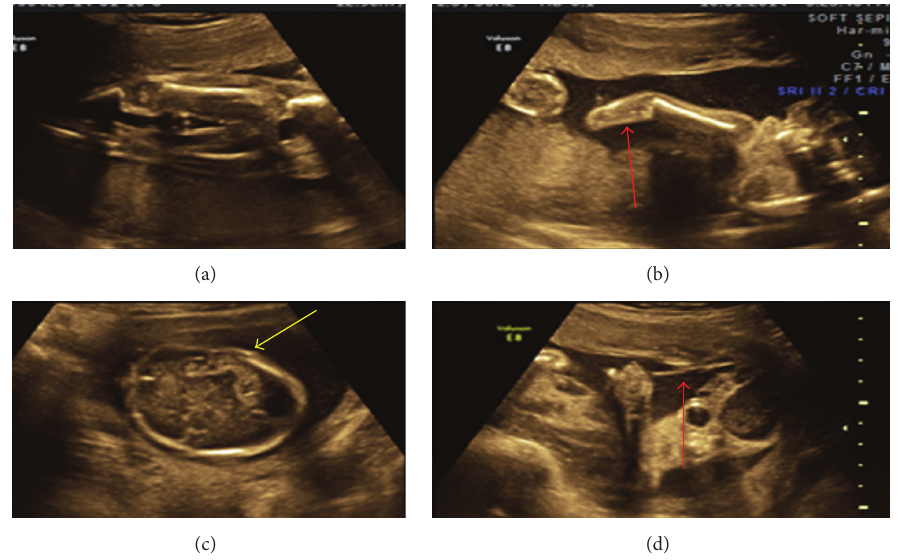
Figure 1: (a) Showing normal lower limbs, (b) showing amputated fore arm with single bone, (c) showing deficient skull vault, and (d) showing amniotic band.